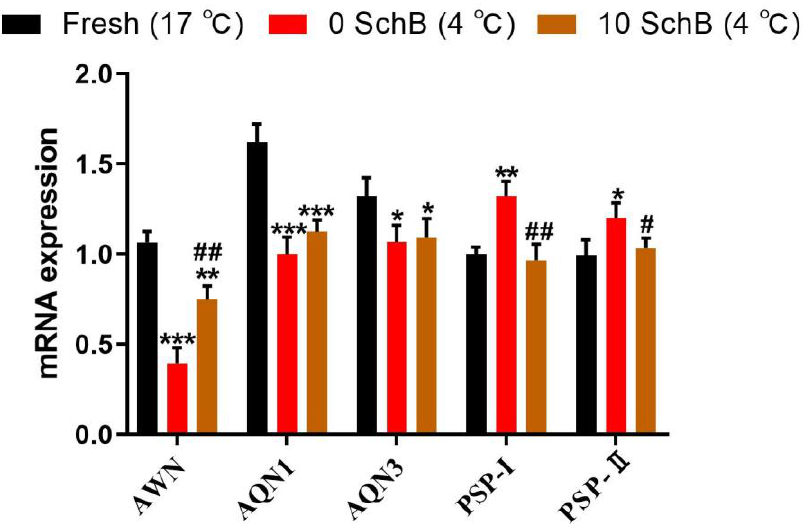
Figure 7. Effects of Sch B on boar sperm mRNA expression of AWM, AQN1, AQN3, PSP-I, and PSP-II in boar sperm: Data are expressed as mean ± SD ( n = 12). ## p < 0.01 and # p < 0.05 vs. 0 Sch B, *** p < 0.001 ** p < 0.01 and * p < 0.05 vs. fresh.